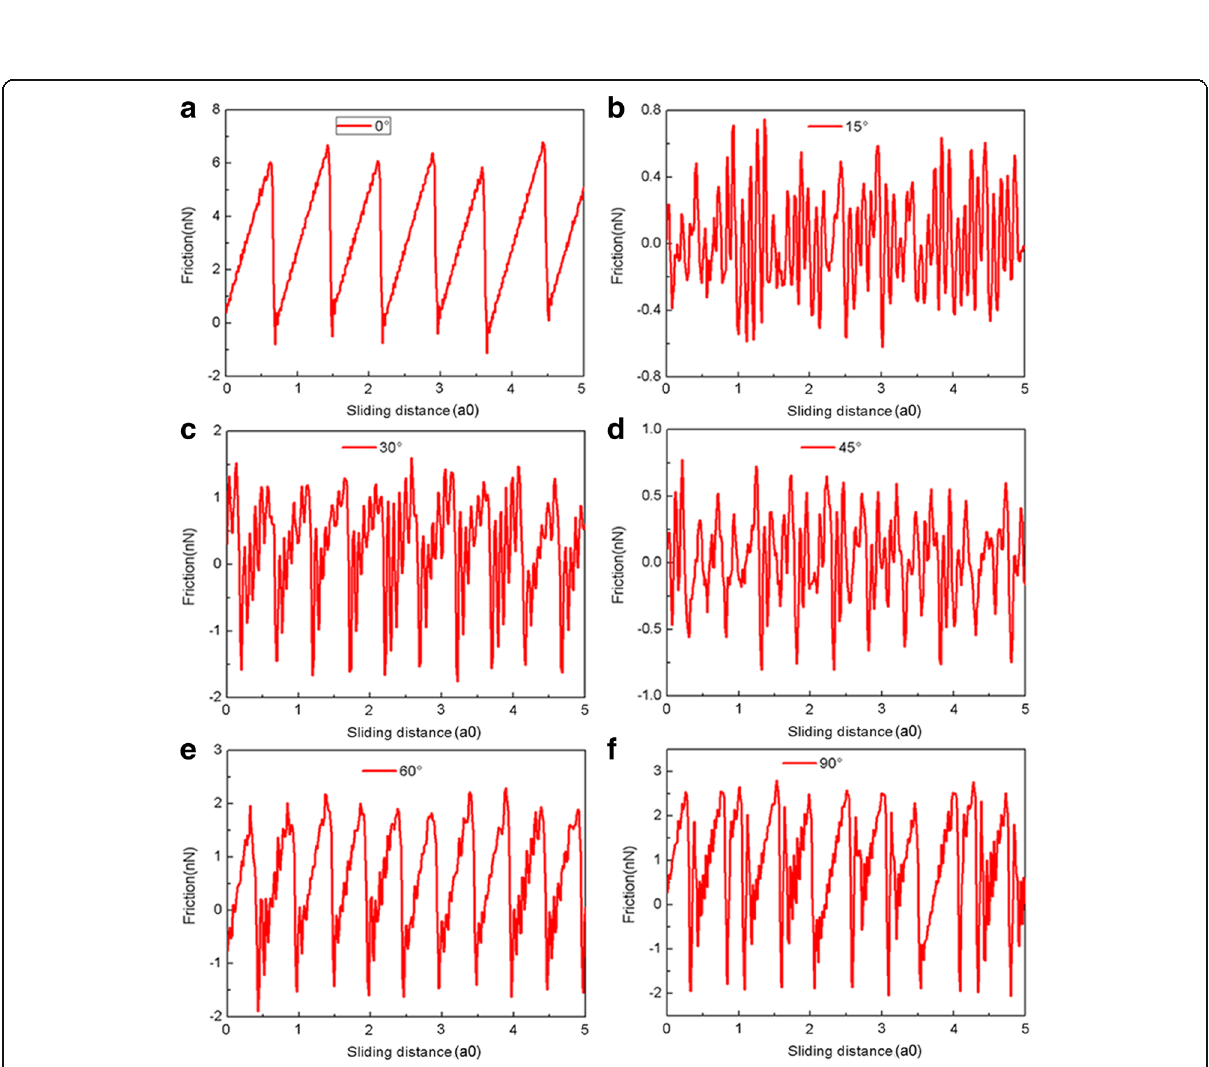
Fig. 5 The friction force vs sliding distance of the 5.8 nm square flake at L = 240 nN for different rotation angles ( θ = 0°, 15°, 30°, 45°, 60°, 90°). a – f correspond to the rotation angle 0°~90°, respectively. Here, a0 (= 9.99 Å) is the lattice spacing of Au(111) along the sliding